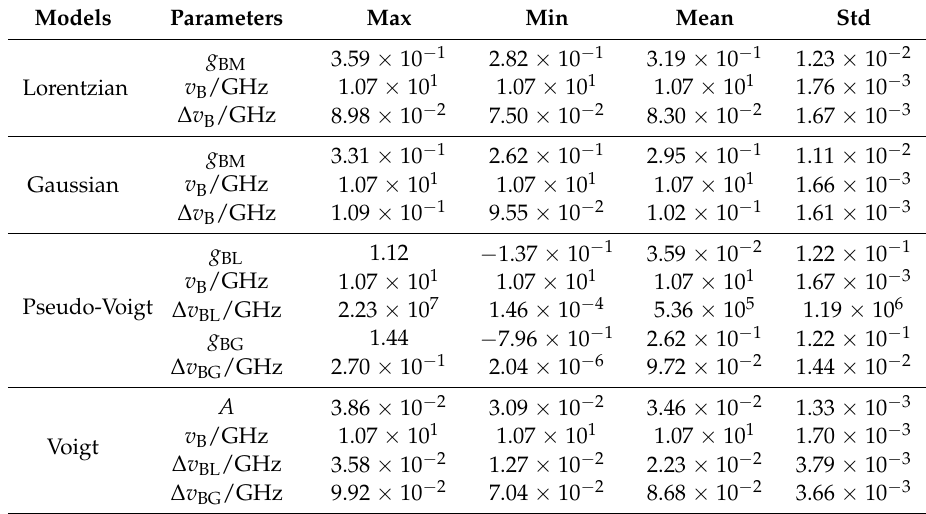
Table 9. Statistical results of model parameters extracted by different models, measured signals with average number of 2 10